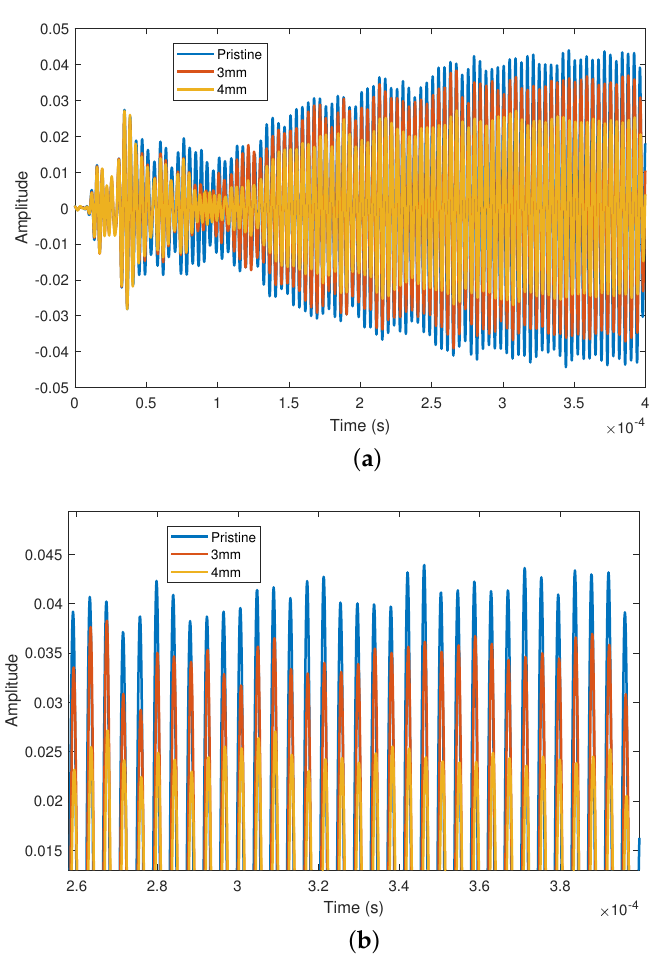
Figure 5. ( a ) Time domain experimental signals of different damage states at 240 kHz; ( b ) zoomed − in portion of ( a ).